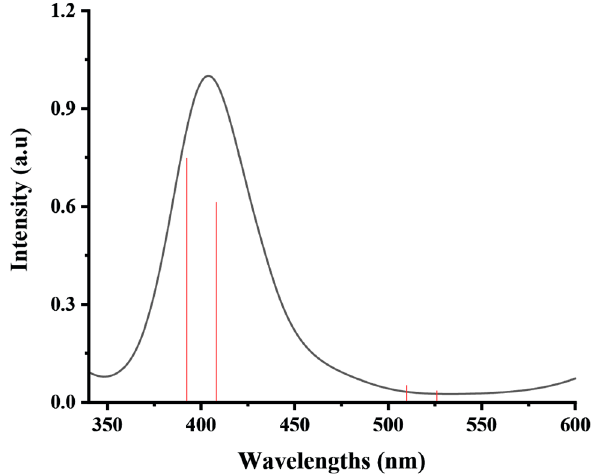
Figure 6. Experimental UV-VIS absorption spectrum of the Ni-TEA complex (black) measured in the form of ethanolic solution (1 × 10 − 5 mol L − 1 ) and its corresponding DFT calculated data (red).